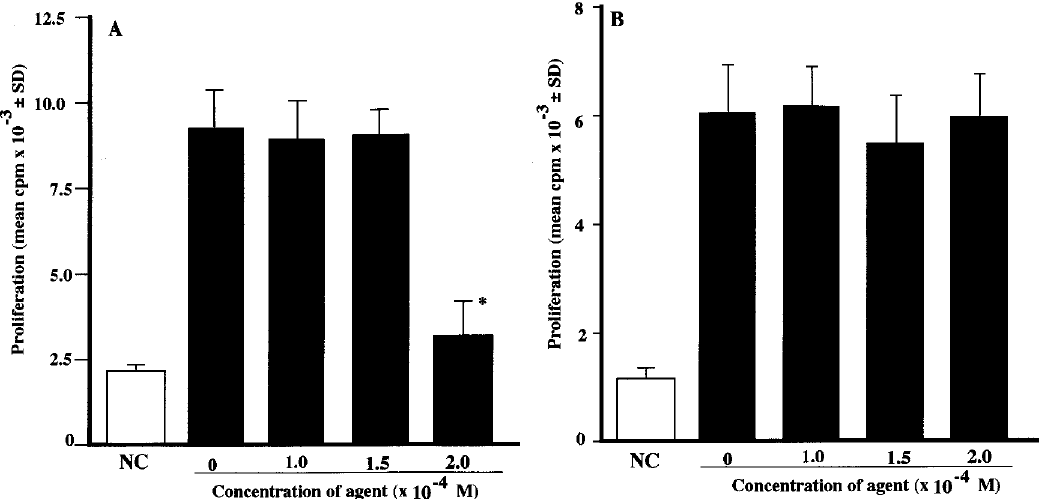
FIG. 1. Influence of epinastine hydrochloride (EP) on in vitro proliferative response of splenic lymphocytes. BALB/c mice were immunized by intraperitoneal injection with 8.0 m g haemocyanin absorbed to 4.0mg aluminium hydroxide in a volume of 0.5ml. Spleen cells (1 ´ 10 5 cells/0.1ml) prepared from mice 10 days later were cultured in the presence of various concentrations of EP for 48h, which were stimulated with specific antigen (A). Splenic T cells (2 ´ 10 5 cells/0.1ml) were also cultured with immobilized anti-CD3 « monoclonal antibody in the presence of various concentrations of EP for 48h (B). These cells were pulsed with 1.0 m Ci 3 H-thymidine for the last 8h of culture. The results were expressed as the mean±SD of five individual mice. NC: non-stimulated control. * P < 0.01, significantly different as compared with no